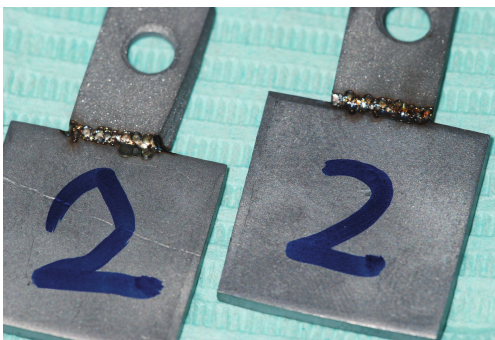
Figure 3: Plates of group B welded by chair-side Nd :YAG laser